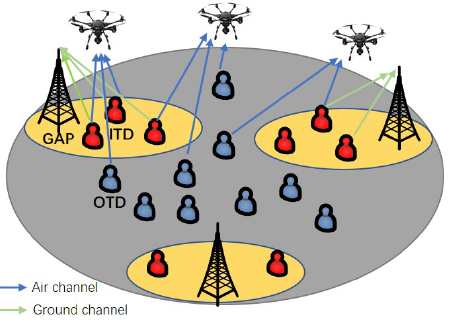
Figure 2. A UAVs-assisted MEC system with air-ground